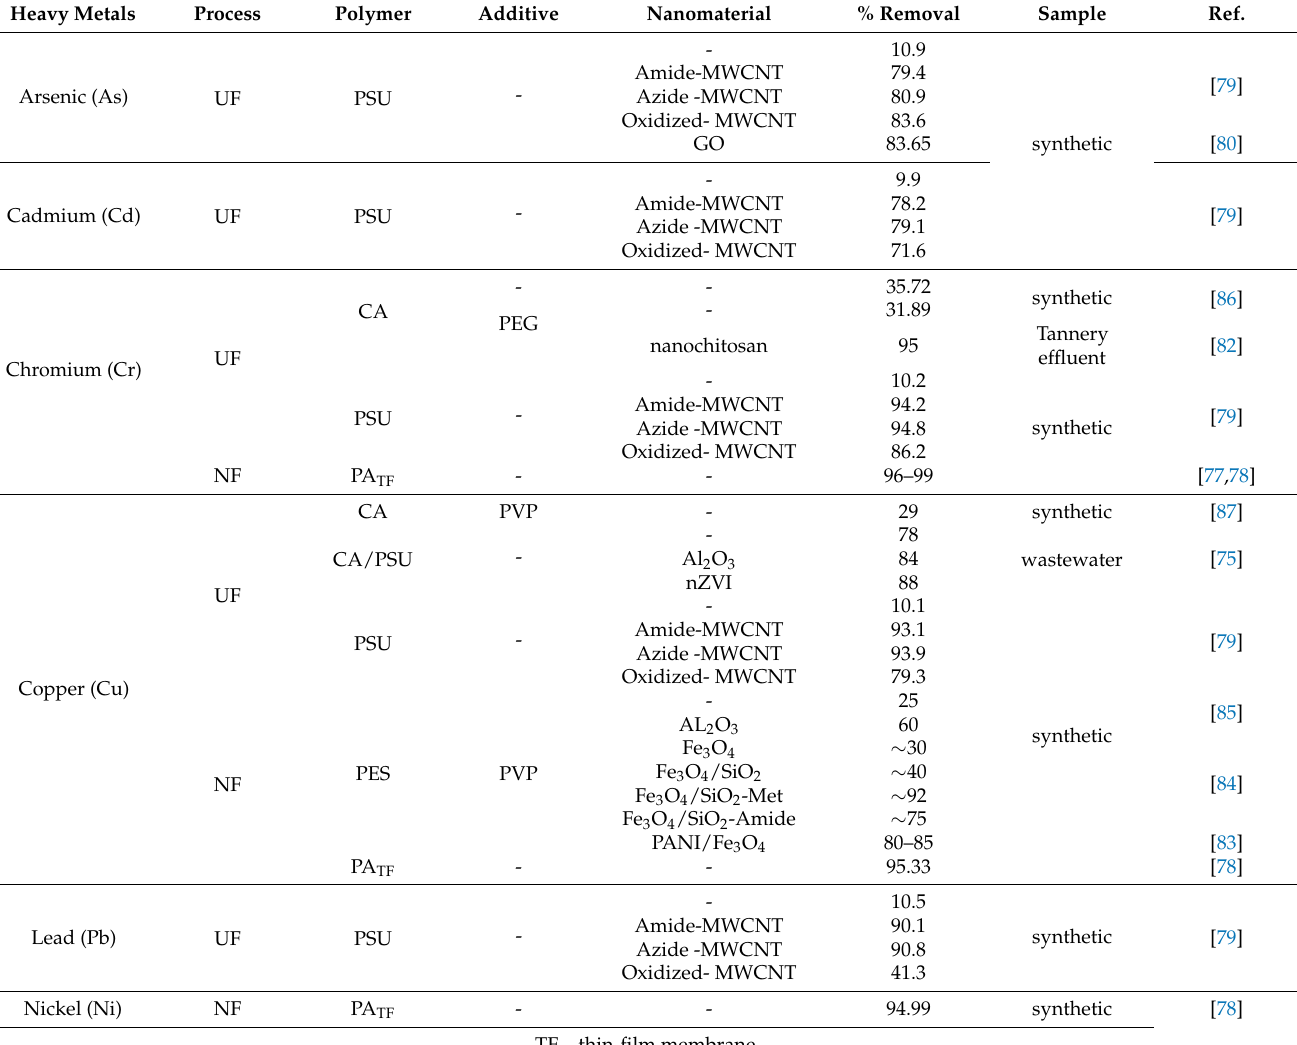
Table 5. Application of polymeric membranes in the purification of water contaminated with heavy